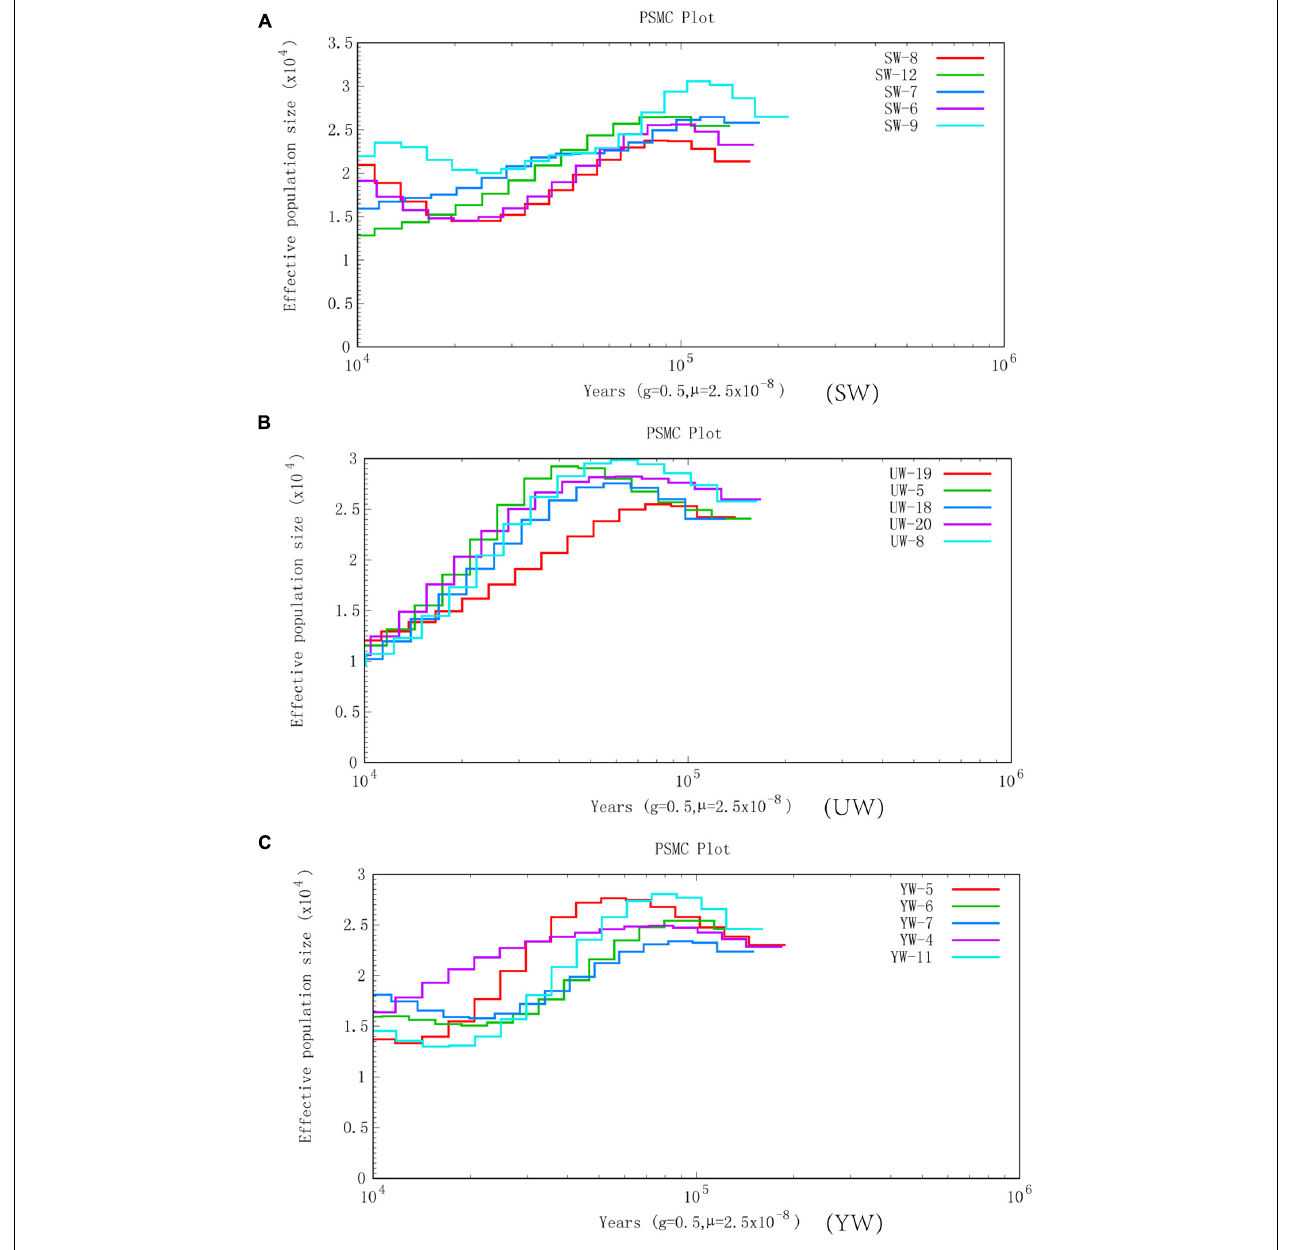
FIGURE 3 | Effective population size is based on PSMC analysis. Abscissa represents different historical periods, ordinate represents the effective population size. In the figure, the generation period is 0.5 years (half a year), and the mutation rate of each generation is 2.5 × 10 − 8 . (A–C) Represents G. uralensis of central, eastern, and southern regions,